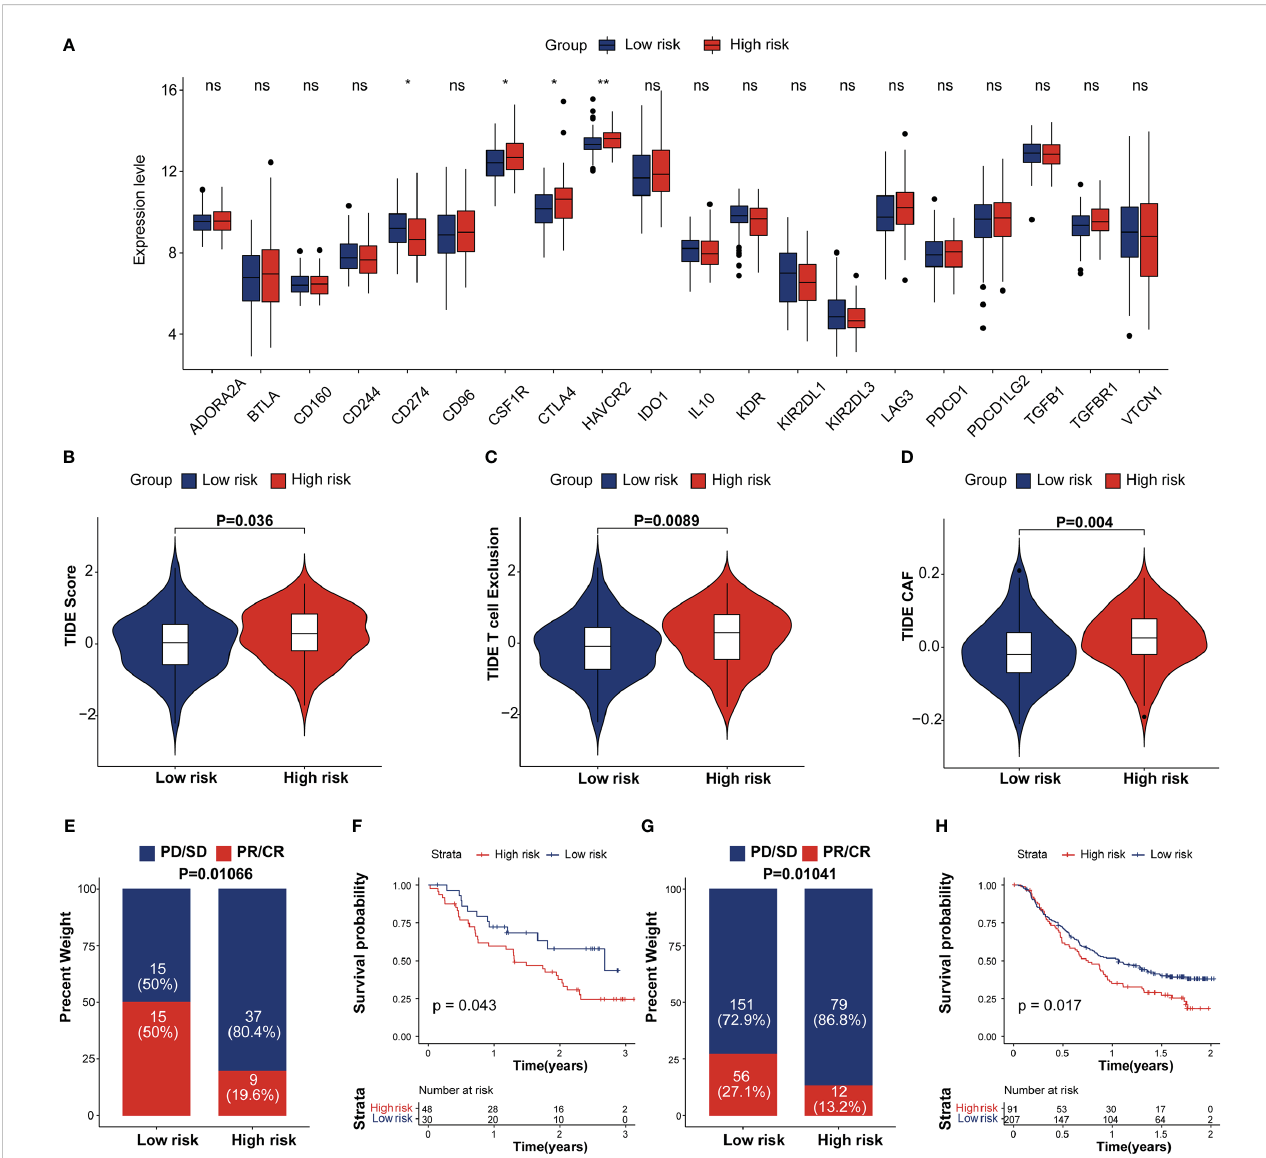
FIGURE 7 Estimation and validation of IRRS in immunotherapeutic. (A) The expression levels of 20 immune checkpoint genes in different IRRS score groups. *p < 0.05; **p < 0.01; ns, no statistical signi fi cance; (B – D) The distribution of TIDE scores, T cell excel in the high-risk and low-risk groups. (E) The distribution of IRRS scores between two immunotherapy response groups in the melanoma cohort. (F) Kaplan – Meier curves for high and low IRRS score patient groups in the melanoma cohort. (G) The distribution of IRRS scores between the two immunotherapy response groups in the IMvigor210 cohort. (H) Kaplan – Meier curves for high and low IRRS score patient groups in the IMvigor210